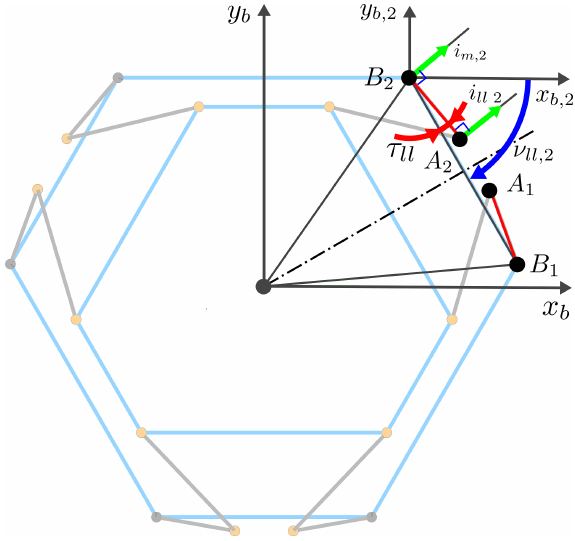
Figure 7. Axes of actuator and lower lever